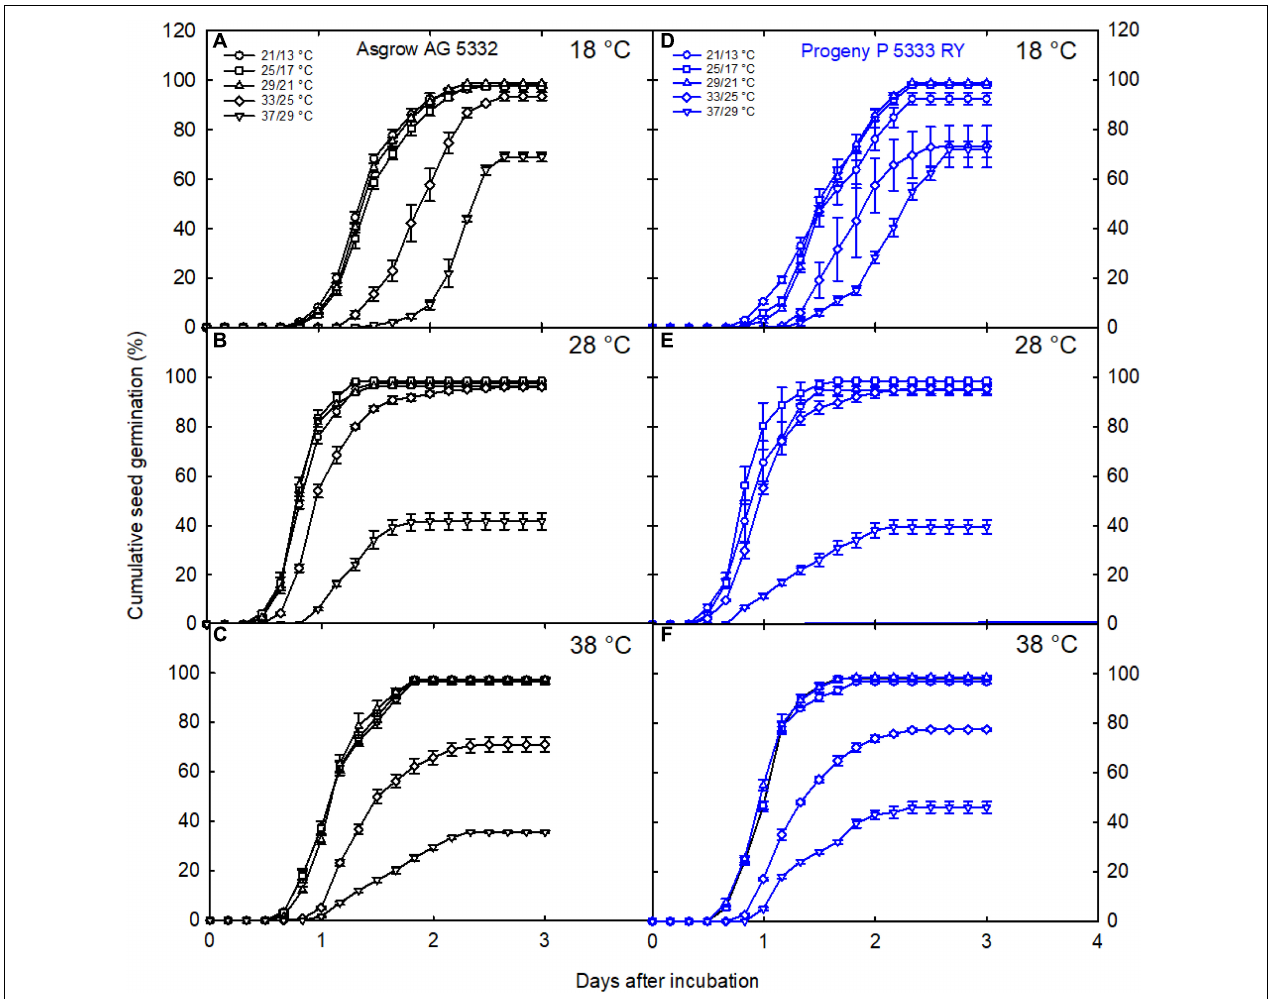
FIGURE 6 | Variation in germination dynamics of seeds exposed to a range growing temperatures during grain filling. Seeds harvested from plants grown under five growing temperatures (21/13, 25/17, 29/21, 33/25, and 37 ◦ C/29 ◦ C) were in vitro germinated at incubation temperatures of 18, 28, and 38 ◦ C for 3 days to measure germination potential in AG (A–C) and PR (D–F) cultivars. The cumulative germination data of each genotype is presented using symbols in response to three incubation temperatures. The germination time course is represented by fitting a three-parameter sigmoidal function to each